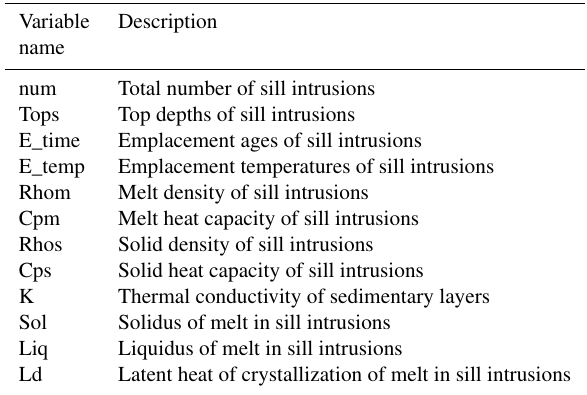
Table 3. List of variables in the “sill” struct variable of the output file.